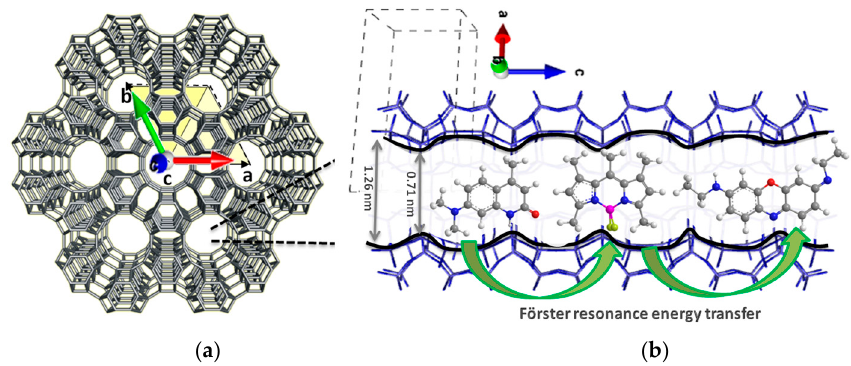
Figure 2. Top view of the LTL zeolite framework, illustrating the hexagonal structure ( a ); and the side view of the channel with a van der Waals opening of 0.71 nm at the smallest and 1.26 nm at the widest place ( b ), suitable for allocating luminescent fluorophores.